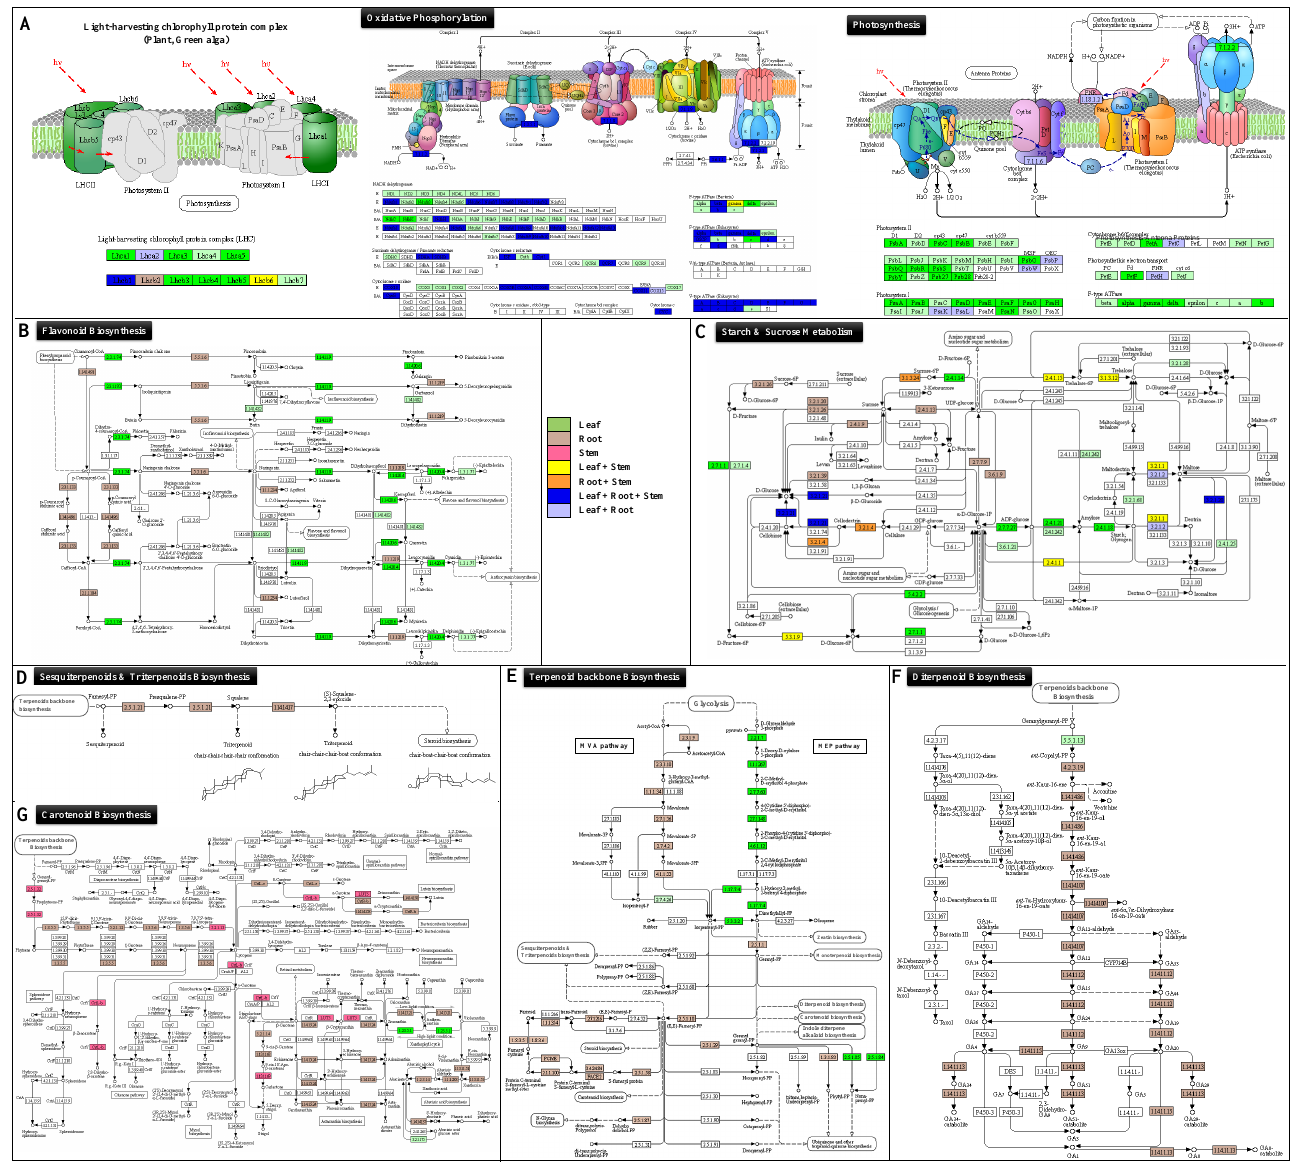
Figure 4 Figure 4. Spatially enriched metabolic pathways in leaf, stem, and root tissue of I. racemosa . ( A ) Signif- icantly enriched photosynthesis and oxidative phosphorylation metabolic pathways. ( B ) Flavonoid biosynthesis; ( C ) starch and sucrose metabolism; ( D – F ) terpenoid metabolic biosynthesis pathways including ( D ) sesqui- and triterpenoids, ( E ) terpenoid backbone biosynthesis & diterpenoid biosyn- thesis; ( G ) Carotenoid biosynthesis in the leaf, stem, and root tissue of I. racemosa. The organ specific spatial enrichment representing (green) enrichment specifically in the leaf tissue; pink in the stem; and brown in the root tissue. Additionally, the unigenes involved in glycosylation and the pectin biosynthetic process, pentose and glucuronate interconversion, jasmonic acid and auxin signaling pathways also exhibited higher enrichment in the root. However, the plastoquinone and tocopherol synthesis pathways corresponding to terpenoid-quinone biosynthesis were expressed in the leaf tissue. This probably indicates root tissues as site of sesquiterpene lactone (SL), secoiridoid, and inulin biosynthesis in I. racemosa (Table